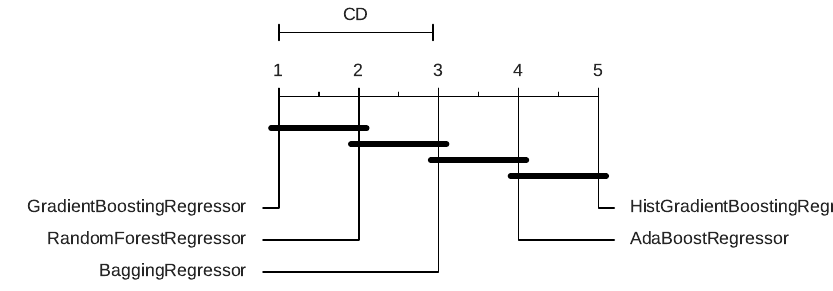
Figure 3. Critical difference diagram for the individual regressors without SDMA.